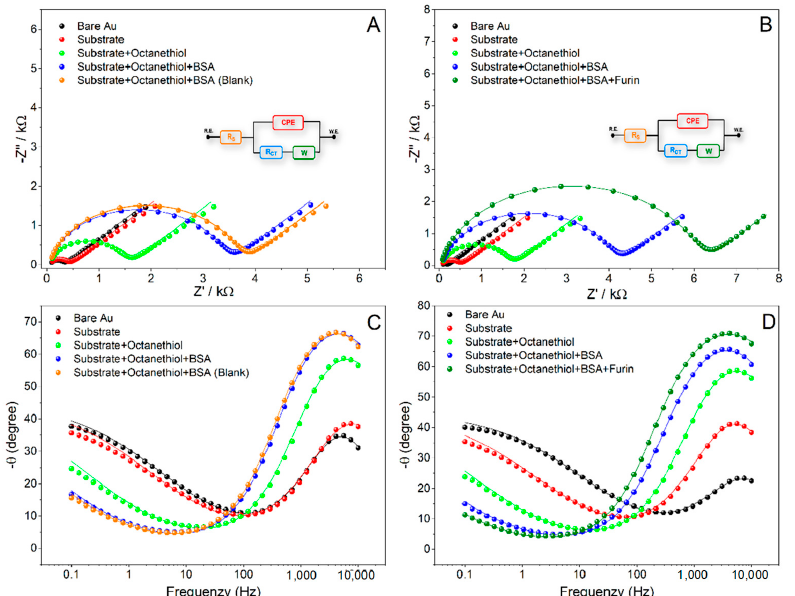
Figure 8. Nyquist ( A , B ) and Bode plots ( C , D ) of unmodified and modified gold electrodes and their interaction with enzyme ( B , D ) and control probes ( A , C ) in an aqueous solution of [Fe(CN 6 ] 3 − /4 − (5 mM), in phosphate buffer (pH 7.11).